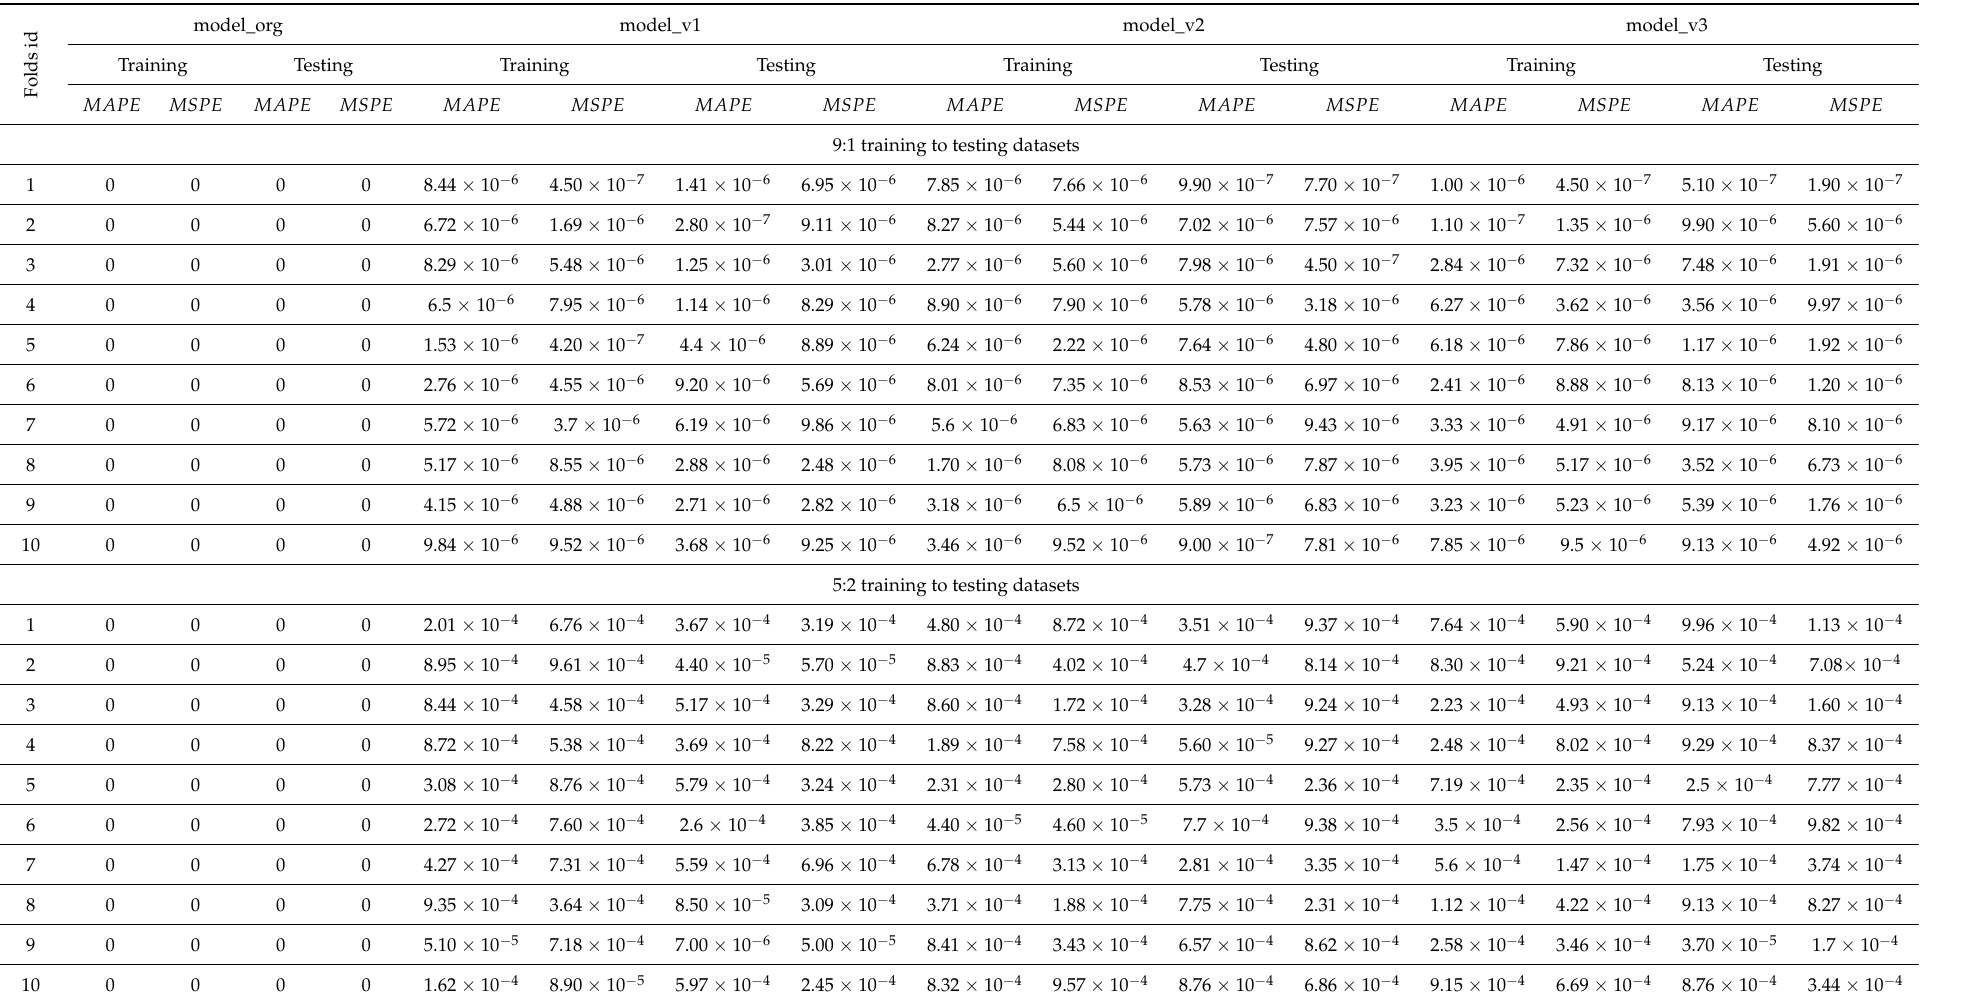
Table 3. MAPE and MSPE of k-fold